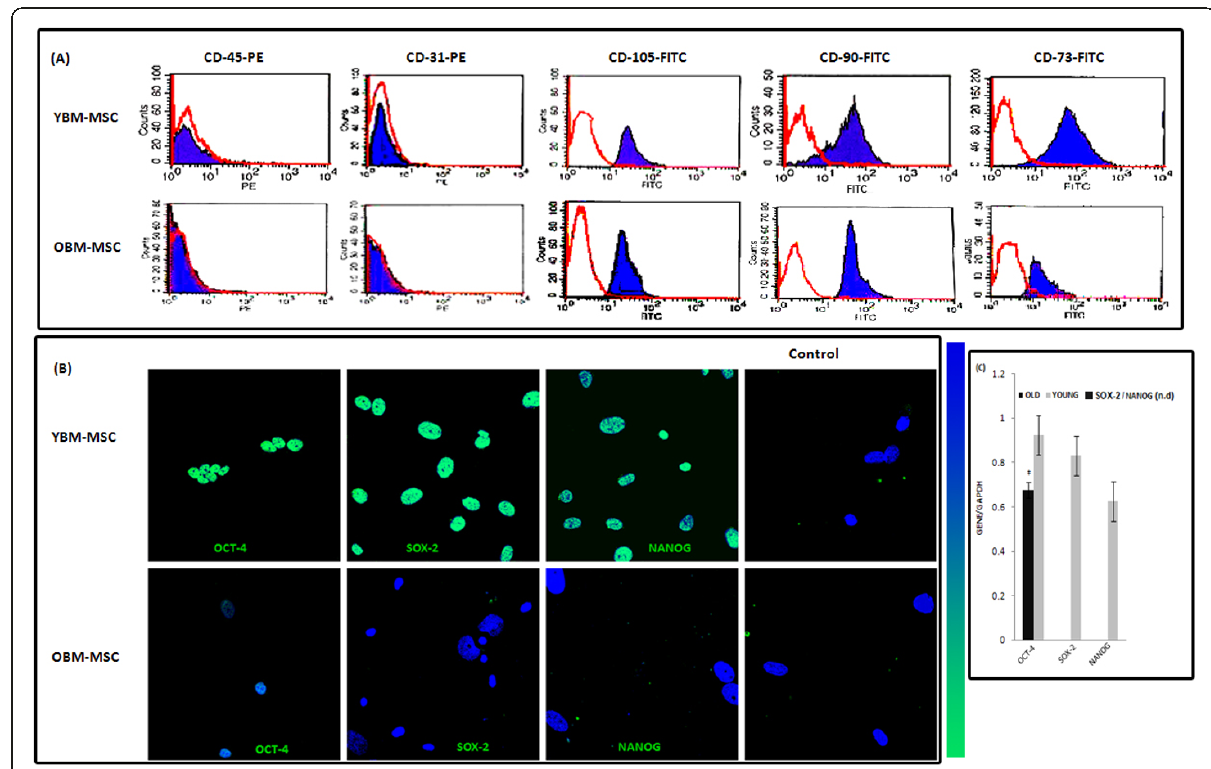
Figure 1 Assessment of pluripotent marker expression and characterization of young and old BM-MSCs: (A) Passage 3 BM-MSCs from young and old rats were harvested and labeled with a PE-coupled antibody against CD45 and CD31, and FITC-coupled antibodies against CD105, CD90 and CD73 or immunoglobin isotype control IgGs and analyzed with FACS. Histograms show counts for specific antibody staining profiles (blue). (B) Immunocytochemical analysis demonstrates that old BM-MSCs express the pluripotent maker Oct-4 but fail to express Sox-2 and NANOG. (C) qPCR analysis for the relative expression of Oct-4, Sox-2 and NANOG in young and old BM-MSCs. We failed to detect Sox-2 and NANOG in old BM-MSCs. Columns show the combined mean ΔΔ C q values of young (n = 4) and old rats (n = 4) for each marker. Data represent relative expression of transcripts normalized relative to GAPDH and expressed as the Mean ± SEM for three biologically independent experiments (n = 3). The ‘‡’ sign indicates a significant difference between the indicated group and any passage 3 groups from younger donors ( p < 0.05). (n.d ~ not